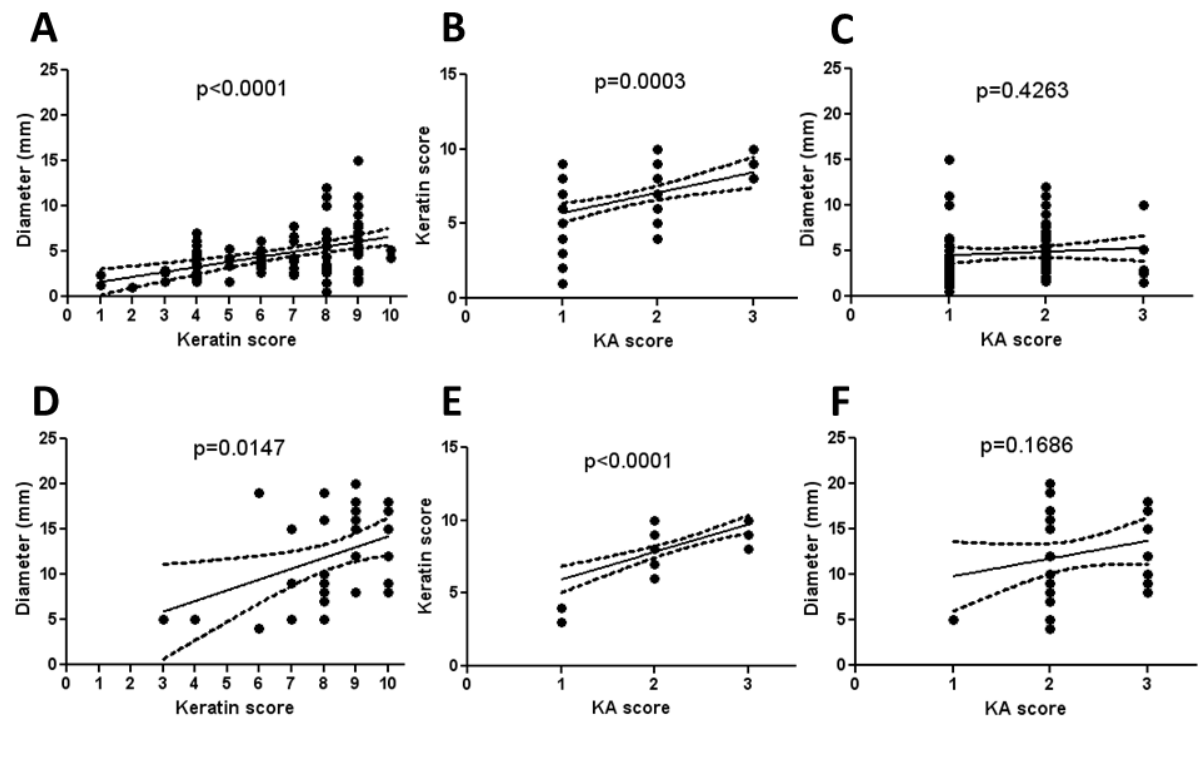
KAs ( D ), as did the keratin score and KA score (( B , E ), respectively). There was